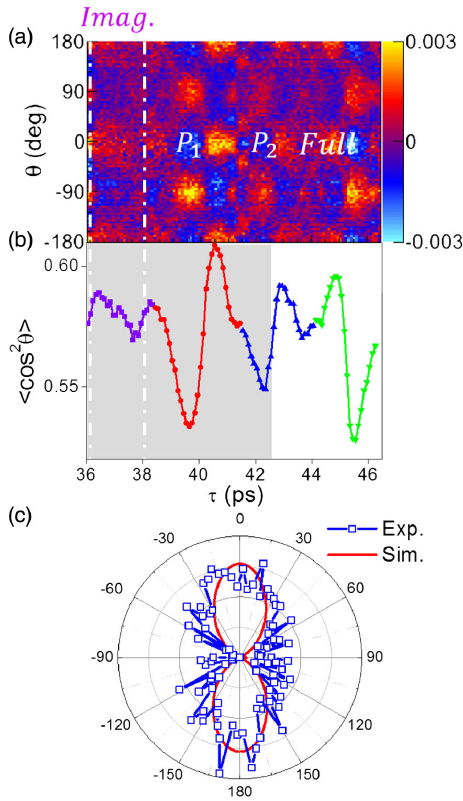
FIG. 8. Experimentally measured and theoretically simu- lated time-dependent angular distributions of the imaginary echo in N 2 O. P 1 and P 2 arrive at − 3 ps and 0 ps, respec- tively. (a) A “ carpet ” describing the angular distribution of the imaginary echo as a function of the probe time delay (see the region of 32.5 – 34.5 ps between the white dashed lines). (b) The alignment factor h cos 2 θ i as a function of the probe delay (red shows the revival of the response to the first pulse, blue that of the second pulse, green depicts the revival of the first full echo, and purple presents the imaginary echo). (c) Polar plots of the imaginary echo around 33 ps (blue is for experiment, red for